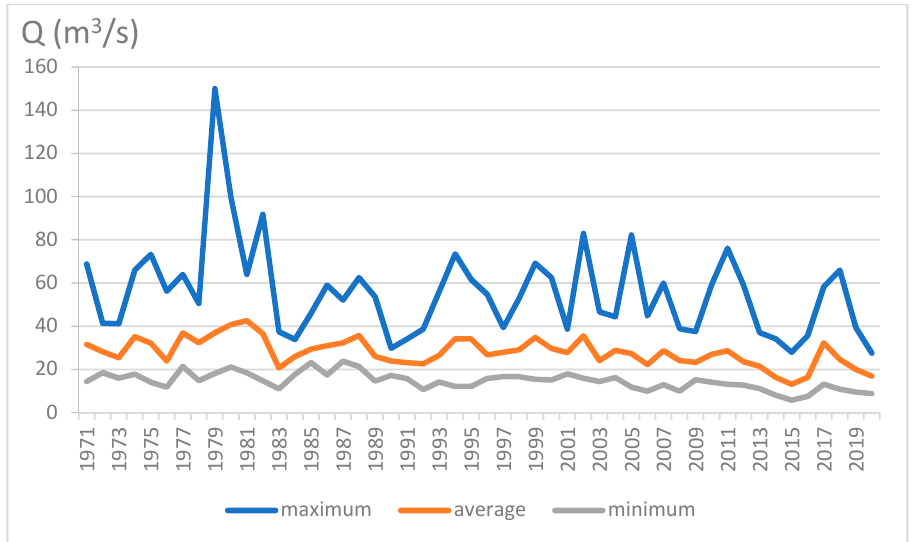
Figure 8. Maximum, average, and minimum annual discharge rates of the Drw ę ca River recorded at the hydrological station in Elgiszewo during 1971–2020. Table 5. Statistical analysis of the hydrological data in Elgiszewo during 1971–2020.